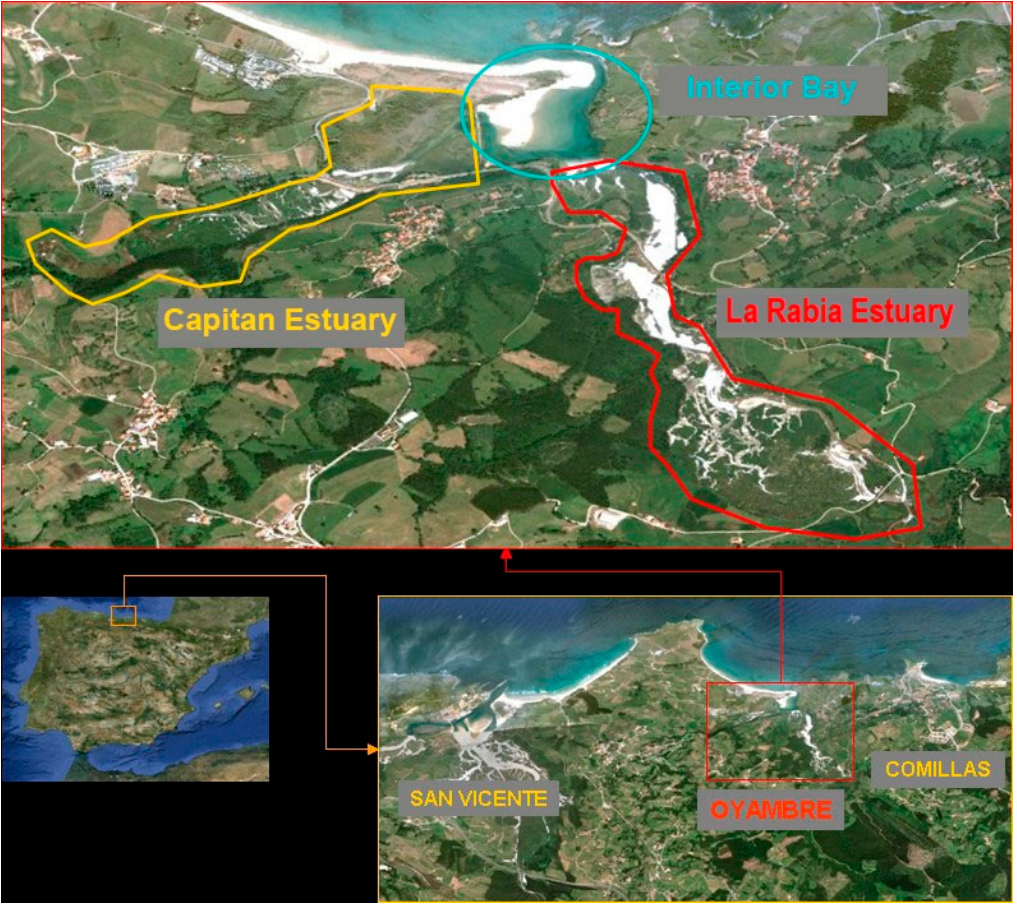
Figure 1. Localization and general view of the studied area.